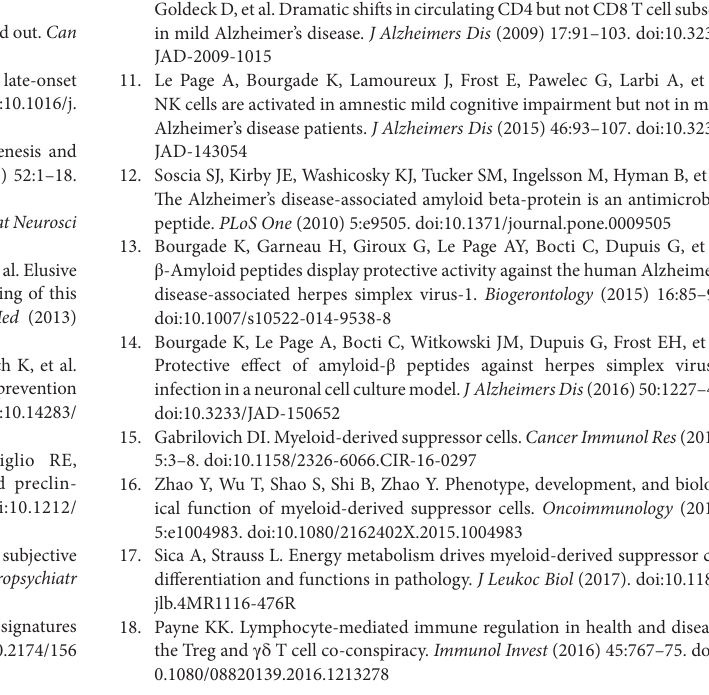
FigUre s1 | Gating strategy used for analysis of regulatory T cells (Tregs) and myeloid-derived suppressor cells (MDSCs) by cytofluorometry. Far Red is a dye used to stain live cells (see Section “Materials and Methods” in the main text). Lin refers to an APC anti-human lineage cocktail (Lin 1) consisting of fluorescence- labeled monoclonal antibodies directed globally against CD3, CD19, CD20 and CD56 (see Section “Materials and Methods” in the main text). Abbreviations are: FSC, forward side scatter; SSC, size side